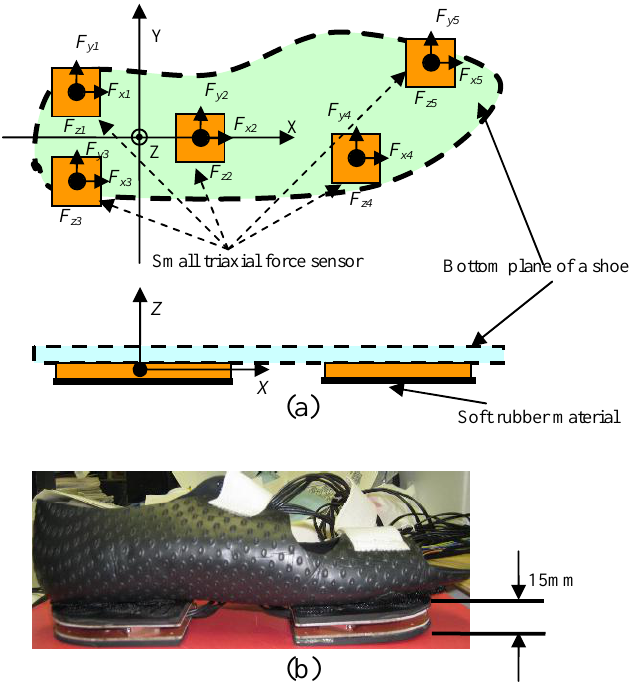
Figure 1. A wearable GRF sensor system constructed using five small triaxial force sensors. (a) Definition of sensors’ ordinate system and sensor mechanism; (b) Prototype of an instrumented shoe for right